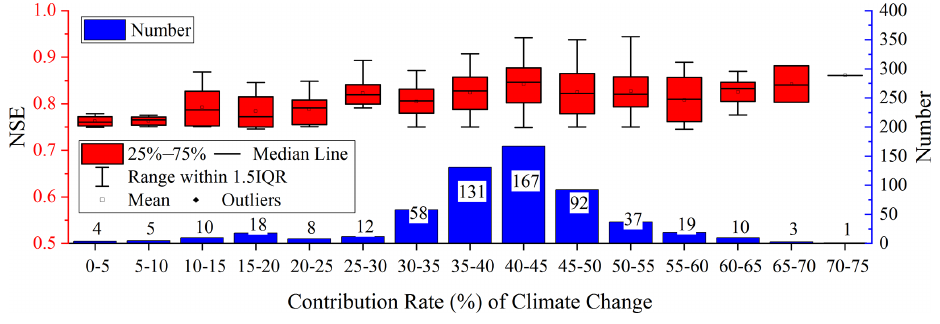
Figure 10. Histogram of the number of simulations of the CR (with 5% steps) of climate change to streamflow reduction in the LR basin at the annual scale and corresponding Nash–Sutcliffe efficiency box plots. Table 5. Hydrological and meteorological elements in the natural (1963–2004) and impacted periods (2005–2015) of the LR basin and their changes during the two